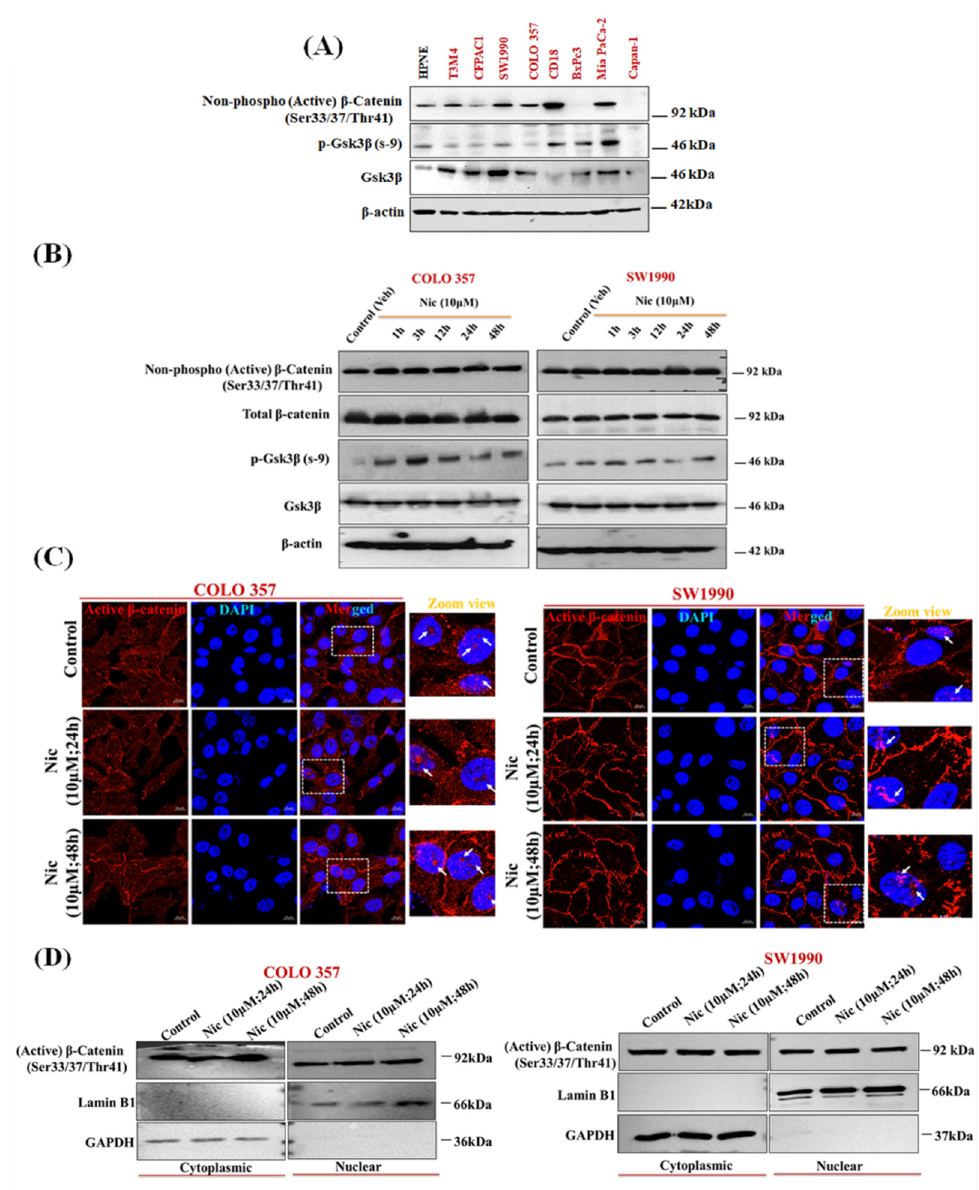
Figure 5. Nic promotes the inactivation of Gsk3 β , and its regulation is independent of β -catenin in PC cells. ( A , B ) Representative Western blot images showing the expression of p-Gsk3 β , Gsk3 β and β -catenin (active) in different PC cell lines ( A ), p-Gsk3 β , Gsk3 β , p- β -catenin (active) and β -catenin (total) at different time points (1, 3, 12 24, and 48 h) in COLO 357, SW1990 cells treated with Nic (10 µ M) ( B ). β -actin was used as loading as an internal loading control. ( C ) Representative confocal laser scanning microscope (CLSM) images showing nuclear translocation of p- β -catenin (active) in Nic treated COLO 357, SW1990 cells for 24 and 48 h. ( D ) Representative Western blots showing the expression of p- β -catenin (active) in cytosolic and nuclear extract of COLO 357, SW1990 cells treated with Nic (10 µ M for 24 and 48 h) as compared to control. GAPDH was used as purity control for cytosolic protein extraction, whereas Lamin B1 was used as purity control for nuclear protein extraction.